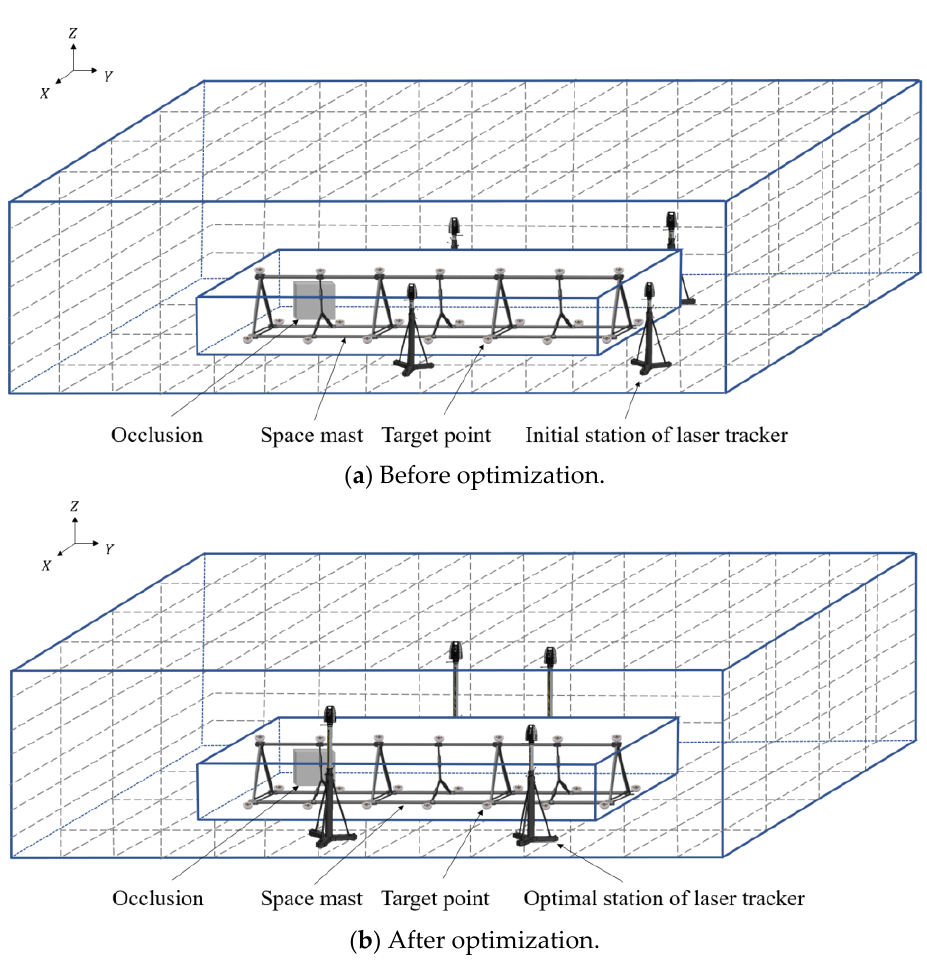
Figure 7. The layout of laser trackers for large-scale measurement. Table 1. Layout of laser trackers before and after the layout optimization.